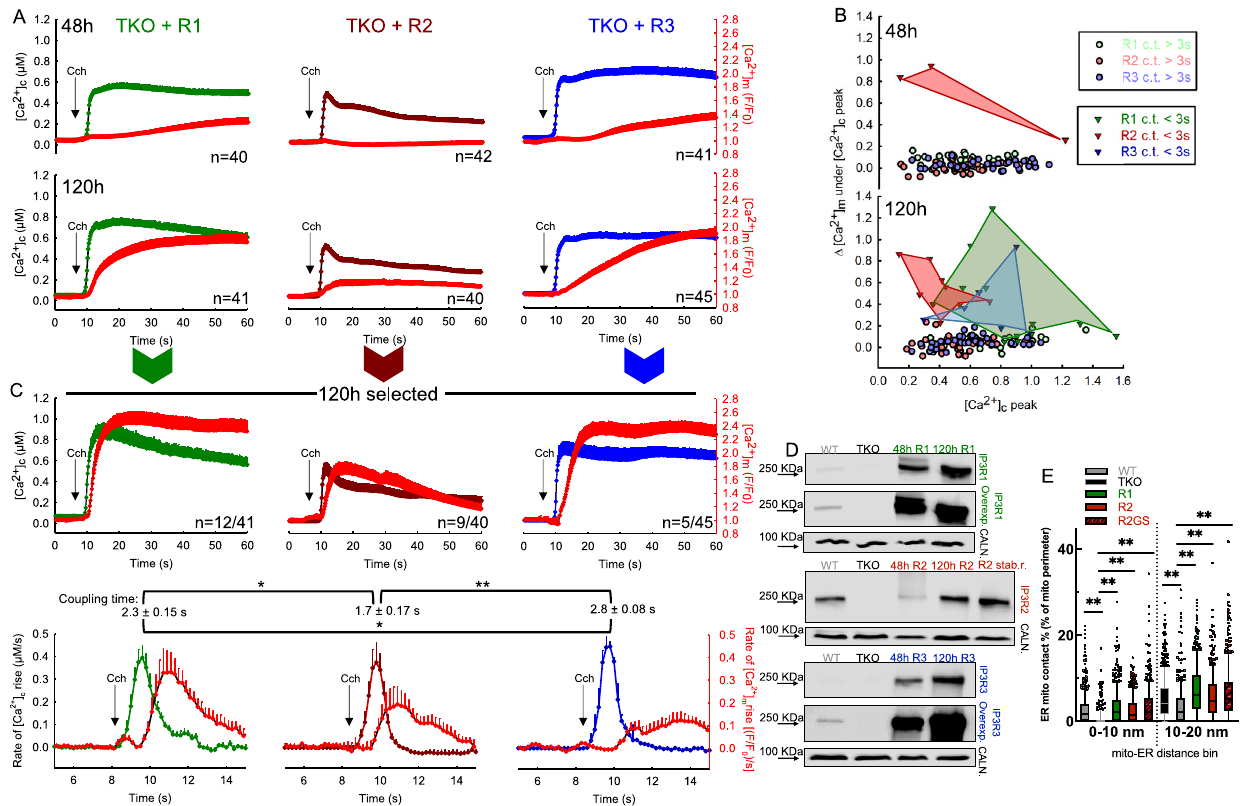
Fig. 2 | IP3R overexpression in TKO cells enhanced ER-mitochondrial Ca 2+ sig- nalingandrestoredcloseERMCs.A MeantimecoursesoftheCch-induced[Ca 2+ ] c responses in R1 (green), R2 (maroon), and R3 (blue) acute 48h (upper panel) and 120h (lower panel) rescue in TKO HEK cells. Corresponding changes in the [Ca 2+ ] m are shownasred tracesoneach graph. B [Ca 2+ ] m atthe time of [Ca 2+ ] c peakplotted as a function of the [Ca 2+ ] c peak in 48h (upper panel) and 120h (lower panel) rescue. The shaded area highlights the cells showing tight ERMC Ca 2+ coupling. C Average [Ca 2+ ] c responses of a selected subpopulation of cells with less than 3s cyto-mitocouplingtimeafter120hofexpressionofIP3R1(green),R2(maroon)and R3 (blue) and the corresponding changes in [Ca 2+ ] m (red) (upper panel). Mean traces of the cytosolic and corresponding mitochondrial rates of Ca 2+ rise in the selected120hacuterescueTKOcells,andthecalculatedaveragecouplingtimefor